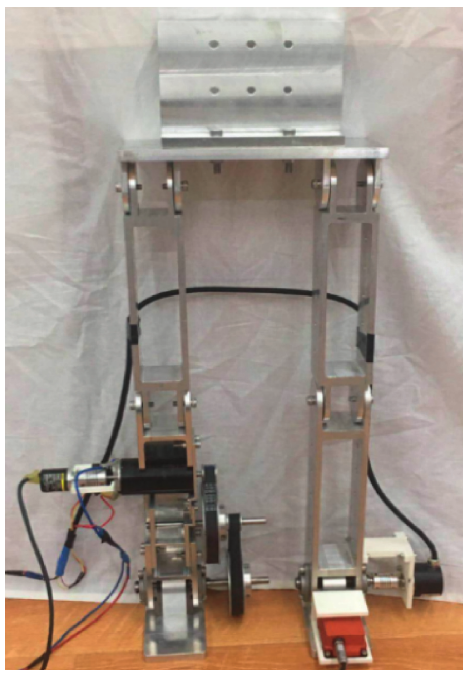
Figure 8: The photo of bipedal robotic